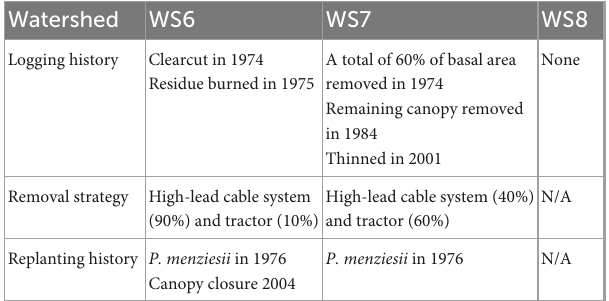
TABLE 1 Management history for each watershed sampled within the H. J. Andrews experimental